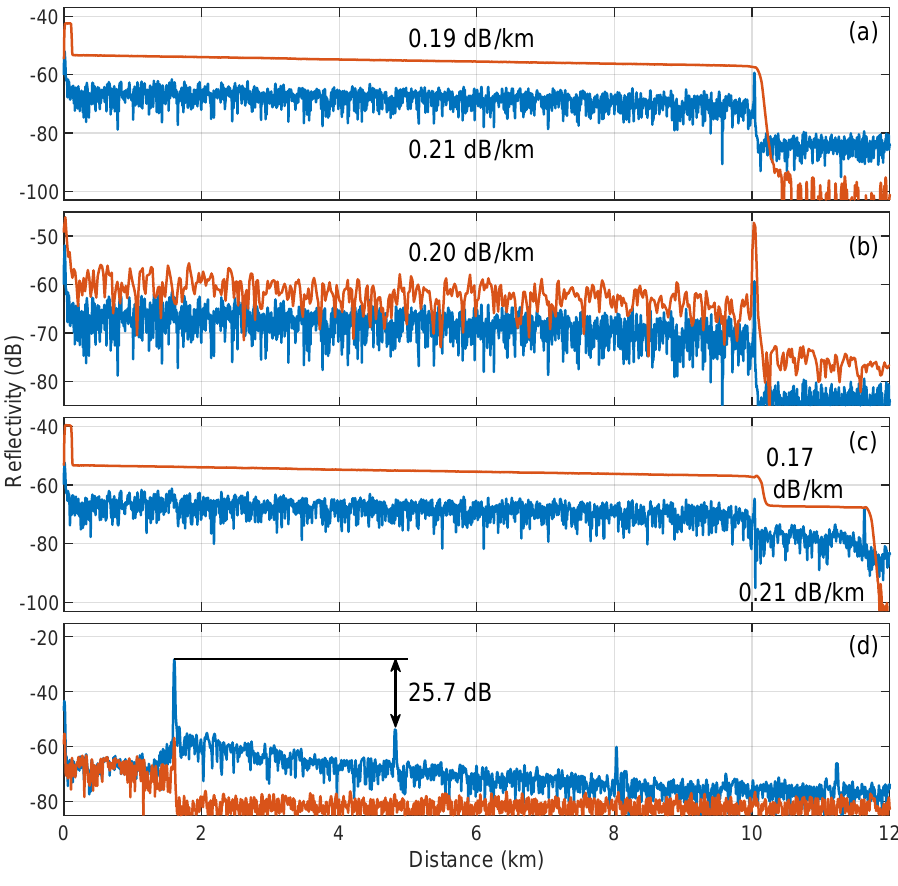
Figure 9. ( a ) Reflectometric traces, in 10log scale, of a 10-km spool of SMF using I-OFDR (blue) and a commercial OTDR (orange); ( b ) I-OFDR traces for 10-km SMF with B = 20 MHz (blue) and B = 5 MHz (orange); ( c ) I-OFDR (blue) and commercial OTDR (orange) measurements for the 10-km SMF coil followed by a 3-dB attenuator and 1.6 km of SMF; and ( d ) I-OFDR traces for 1.6-km SMF ended in PC (blue) and APC (orange) connectors. The acquisition time was 30 s at a pulse width of 1 µ s for the OTDR and (cid:46) 2 min for the